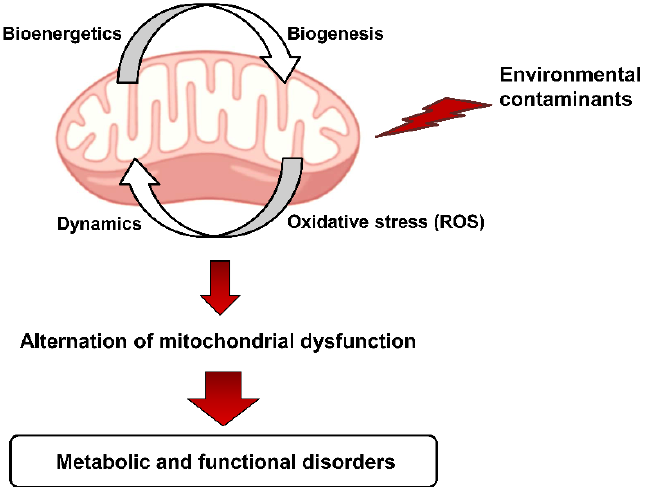
Figure 1. Environmental contaminant-induced mitochondrial dysfunction may lead to various dis- eases.